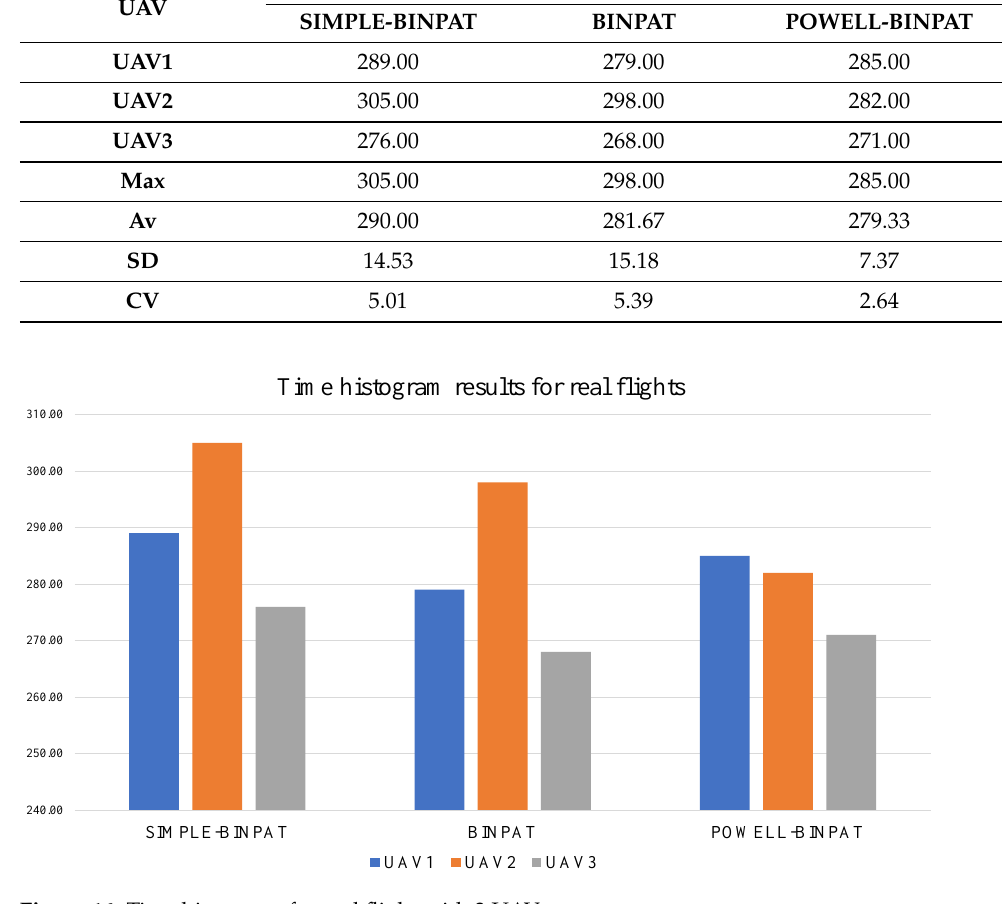
Figure 16. Time histogram for real flight with 3